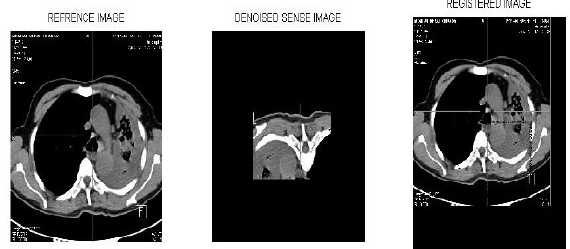
Fig 2. Image Registration for Chest CT with Noise